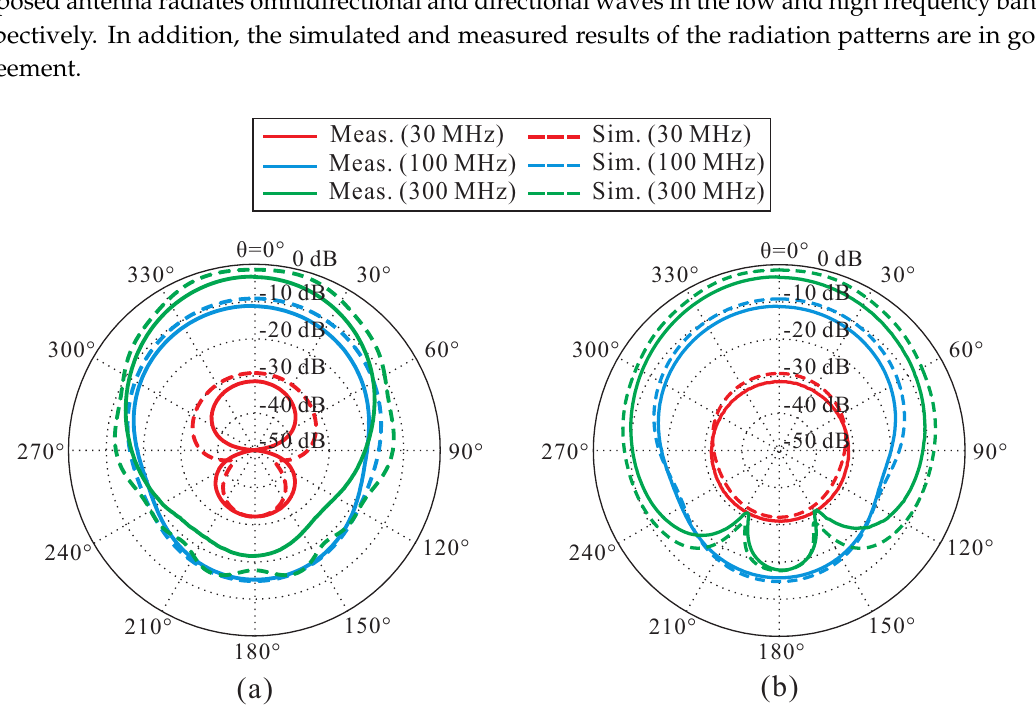
Figure 7. Simulated and measured radiation patterns of the proposed antenna at 30, 100, and 300 MHz: ( a ) xz -plane and ( b ) yz